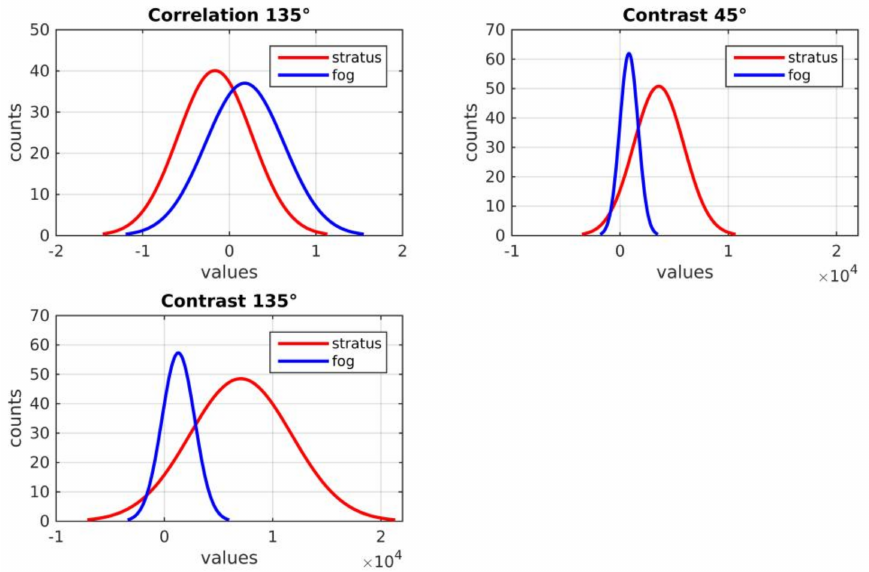
Figure 2. Distributions of textural features selected by the Fisher criterion. Red lines indicate pixels with stratus, blue lines with